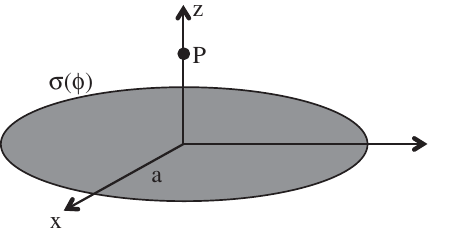
FIG. 2. An example of the canonical exam problem on con- tinuous charge